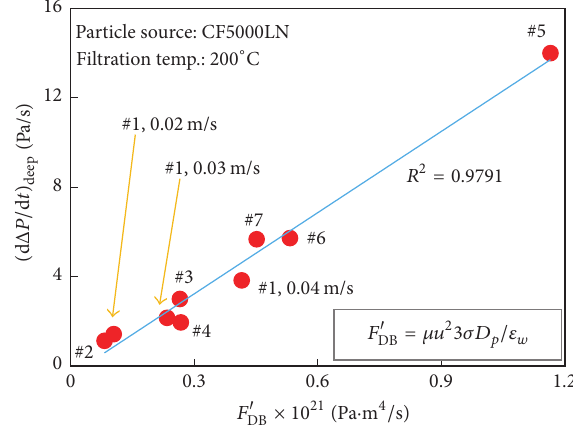
Figure 9: The relationship between the porosity 𝜀 𝑤 and the diameter 𝐷 𝑝 .